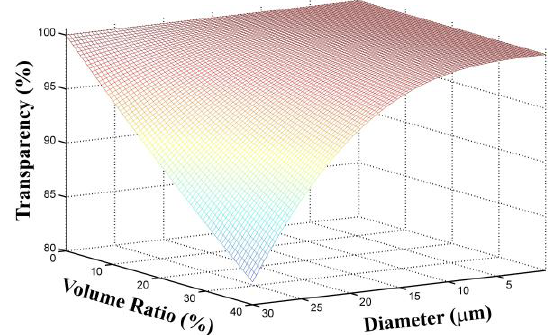
Figure 1. Transparency of cyclo-olefin polymer (COP)–TiO 2 composites as a function of TiO 2 particle diameter and the volume ratio calculated by using Rayleigh theory, where the refractive index of TiO 2 is 6.30, that of COP is 1.52, thickness = 100 μm, and frequency = 1 THz, respectively.